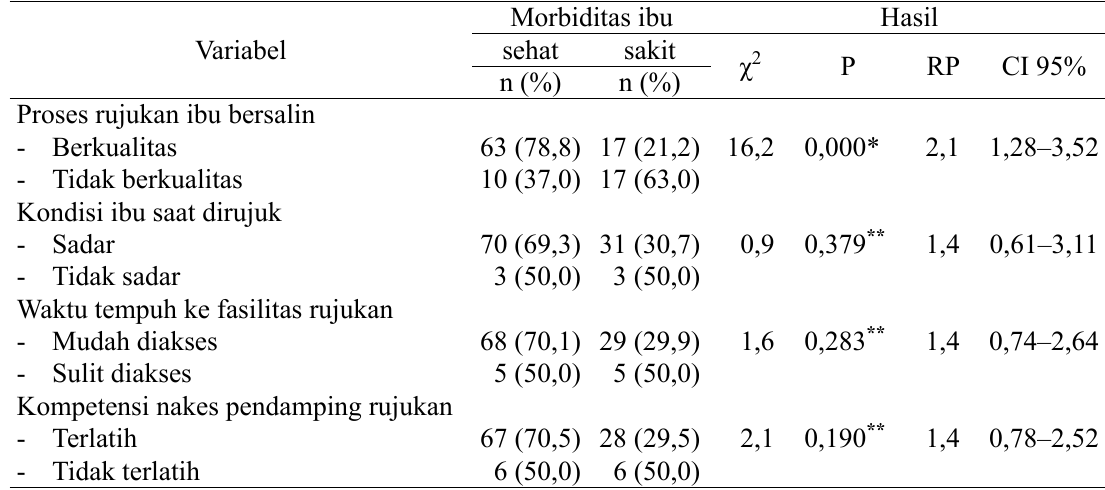
Tabel 4. Analisis c hi square proses rujukan ibu bersalin, kondisi ibu, waktu tempuh,